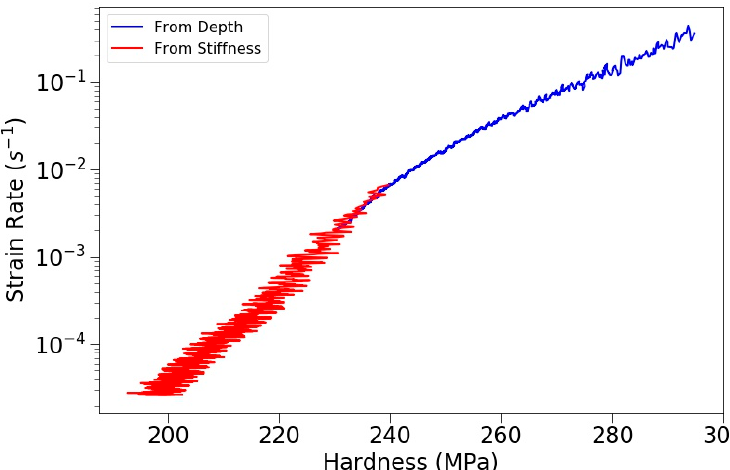
Figure 6. Plot of indentation strain rate vs. hardness for a 3600-s test (derived from the data shown in Figures 4 and 5). The hardness and strain rate for the blue data are determined from the displacement data from the first 10 s of the test, a time scale too short for significant thermal drift. For the remainder of the test, the hardness and strain rate are determined from the contact stiffness, shown in red, which is independent of thermal drift.